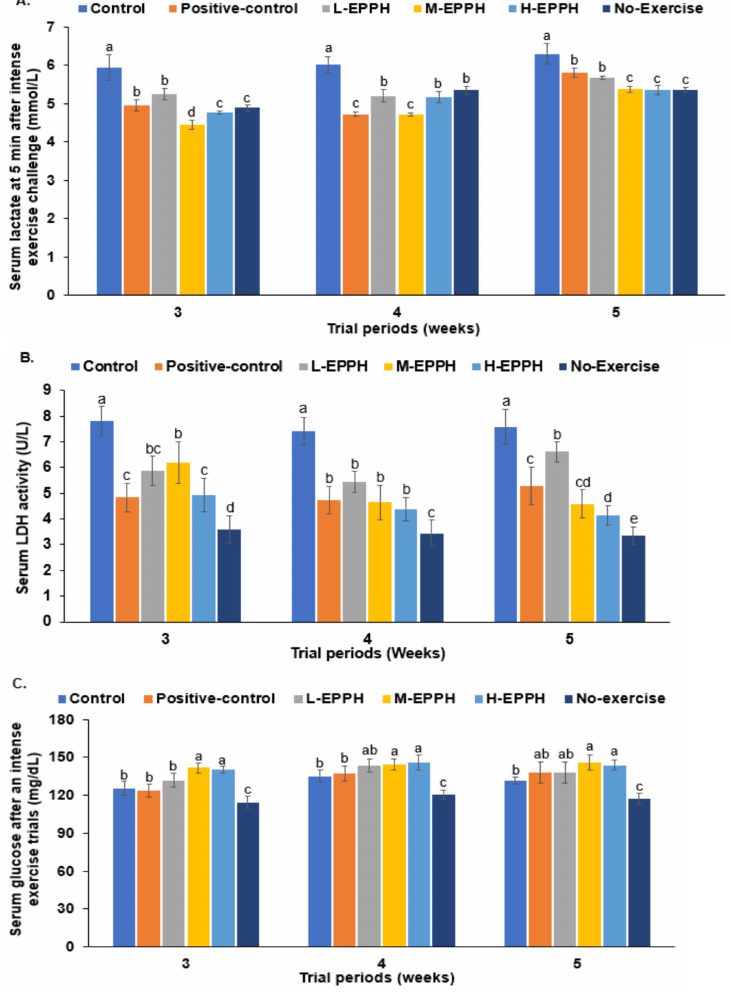
Figure 3. Metabolites related to exercise-induced fatigue at 5 min after intense exercise; ( A ) serum lactate concentrations; ( B ) LDH activity in the serum; ( C ) serum glucose concentrations. Bars and error bars represent means ± standard deviation (SD; n = 10). The rats with exercise-induced fatigue had oral administration of distilled water for the control group, porcine placenta enzyme hydrolysates (EPPH) dissolved in distilled water for experimental groups, and glutathione (100 mg/kg body weight) for the positive-control group. EPPH (0.08, 0.16, and 0.32 mL/kg body weight) was orally provided with a feeding needle for the L-EPPH, M-EPPH, and H-EPPH groups, respectively, for 6 weeks. The rats that had no exercise-induced fatigue and oral administration of distilled water were designated the no-exercise group. a,b,c,d Different letters on the bars indicate significant differences among the groups by Tukey test at p <